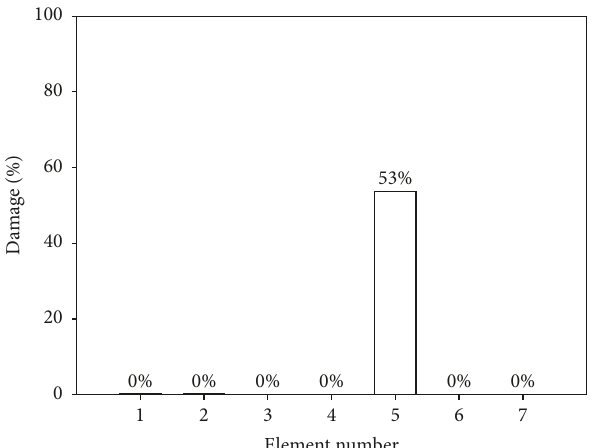
Figure 14: Spring system. Damage quantification results from the proposed CNN model based on three different images with noise levels of 2%, 4%, and 6%.